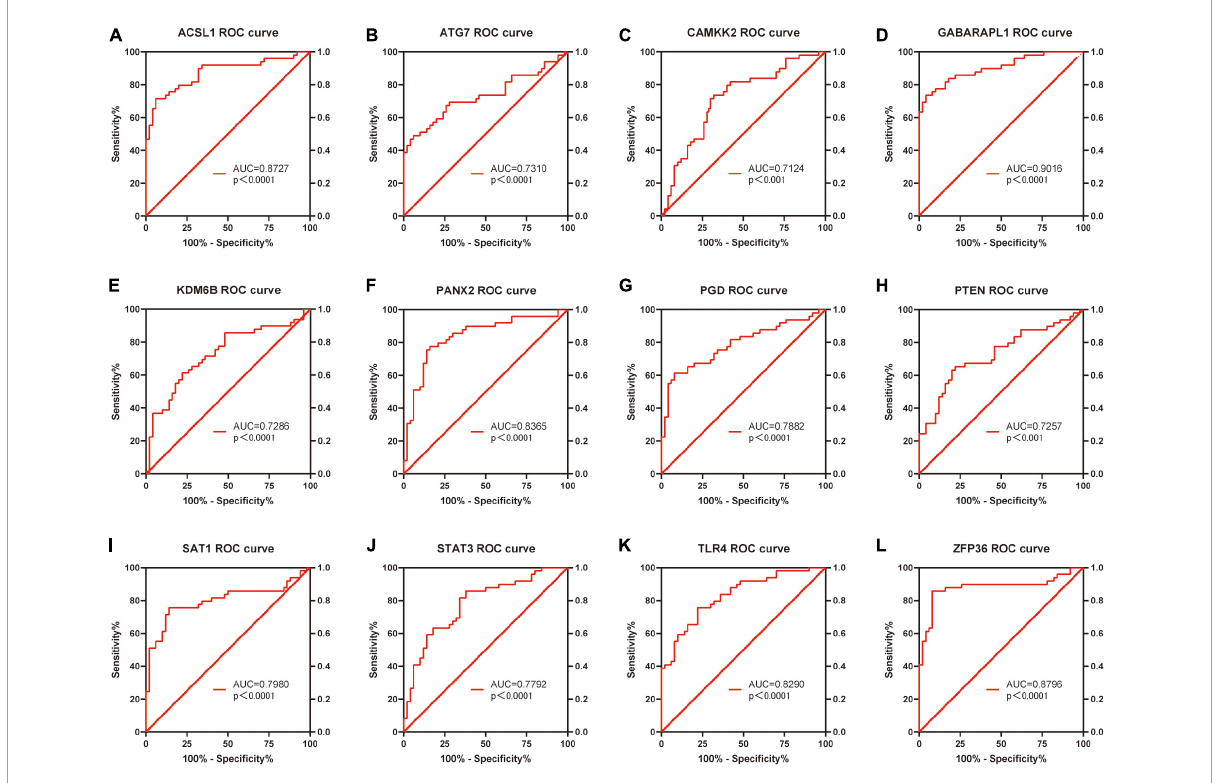
FIGURE7 Receiver operating characteristic curve analysis of the top 12 ranked AUC values.